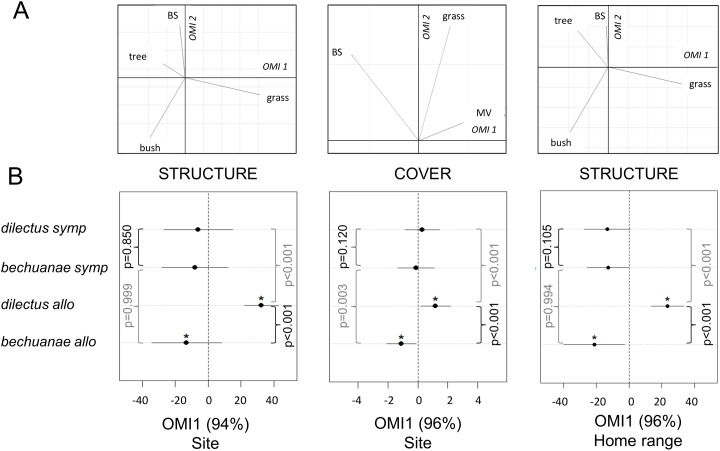
Habitat niche divergence in sympatry and allopatry.Habitat divergence between allopatric (allo) and sympatric (symp) populations of the two species as assessed with Outlying Mean Index (OMI) analyses. The upper row (A) shows the relative contribution of the different habitat variables: vegetation structure (tree, grass, bush and bare soil (BS)) and cover (bare soil (BS), grass and mouse visibility (MV)) to the first two OMI axes. The lower row (B) indicates the position (dot) and breadth (line) of each species niche along the first OMI axis (* when significantly different from random expectation). The p-values of Tukey tests are given for every pair comparison (black: inter-specific, grey: intra-specific).